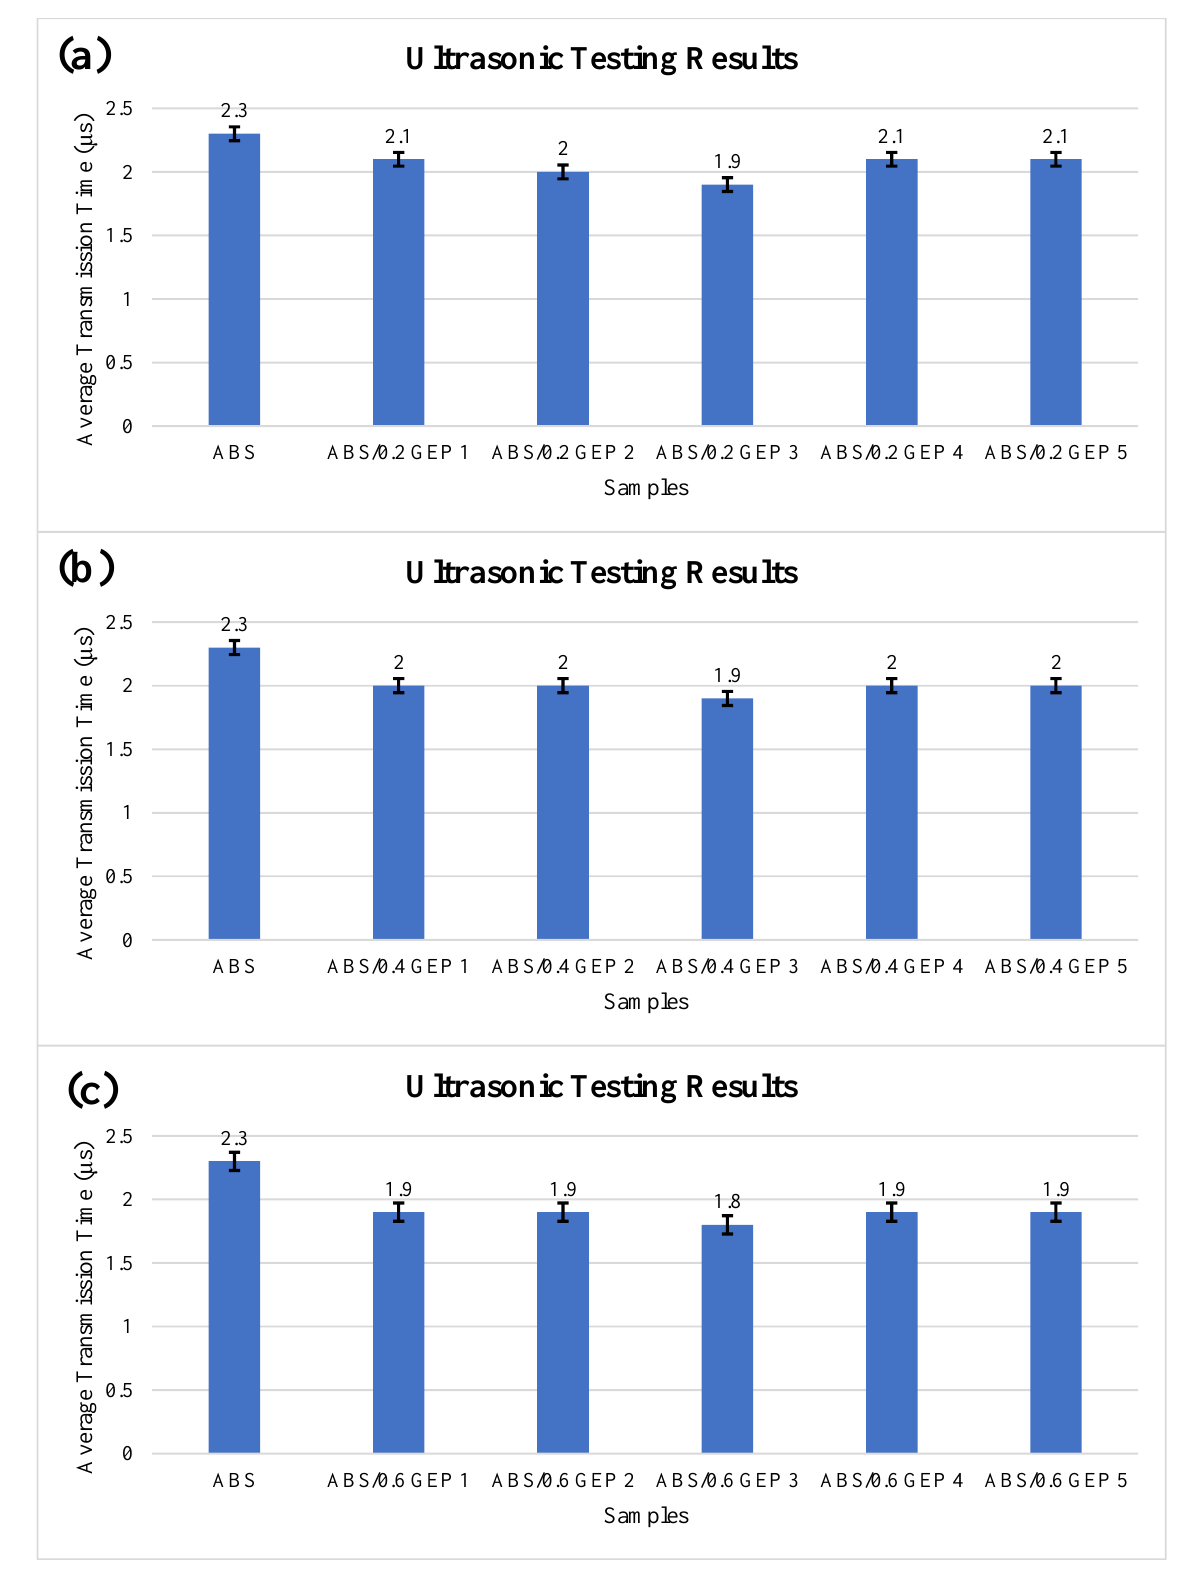
Figure 8. Ultrasonic testing results: ( a ) ABS/0.2 GEP composites with ABS; ( b ) ABS/0.4 GEP composites with ABS; ( c ) ABS/0.6 GEP composites with ABS. ABS/0.2 GEP composites showed varied transmission times with the lowest value observed as 1.9 µs for three-layered ABS/0.2 GEP composites. The double-layered ABS/0.2 GEP composites showed a transmission time of 2.0 µs and the highest transmis-